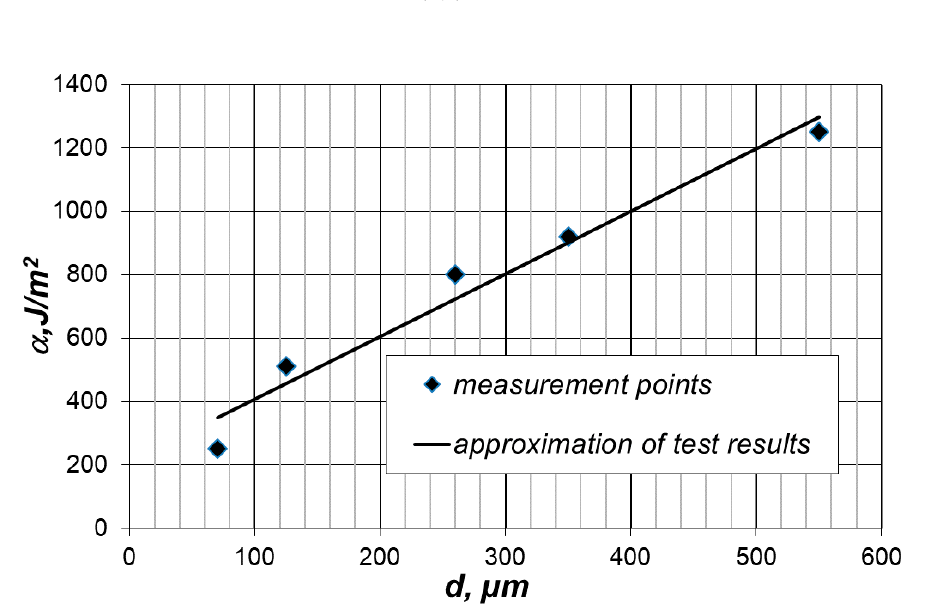
Figure 3. Value of the surface density of the grinding energy as a function of the feed size (average grain size).